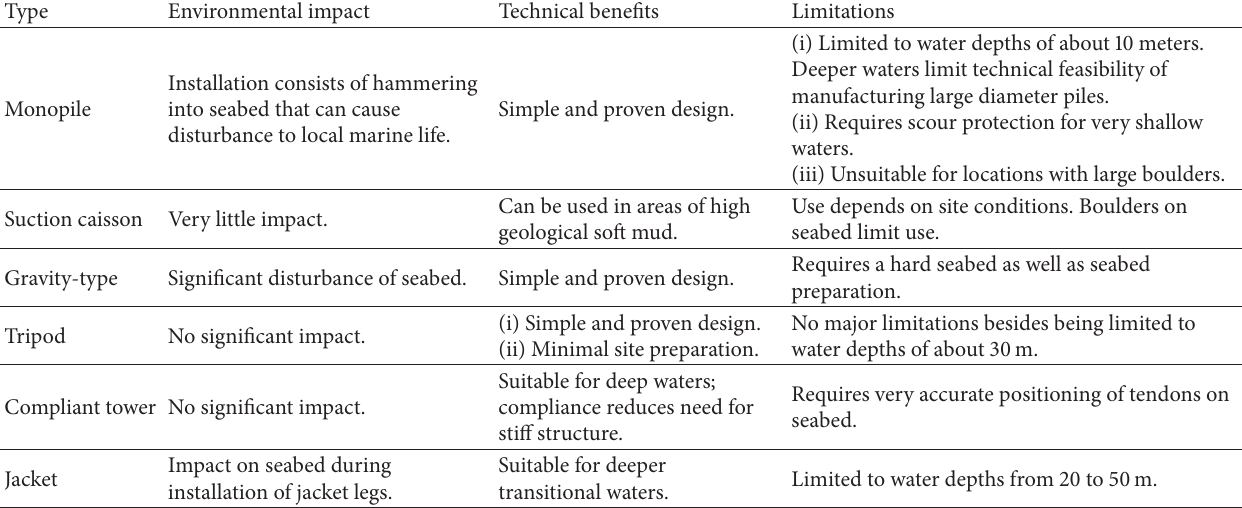
Table 1: Comparison of common foundations (Source: